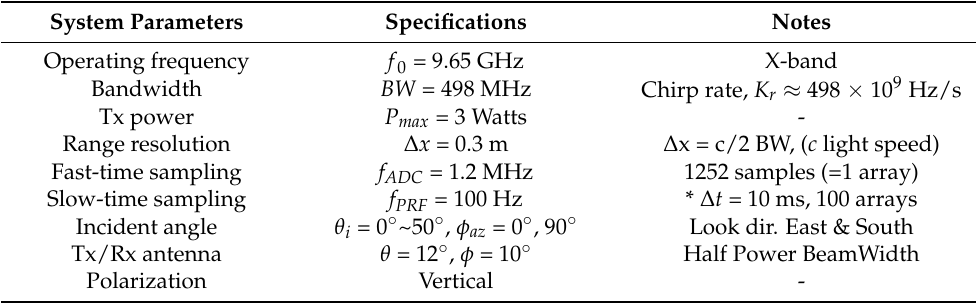
Figure 1. The appearance of the self-manufactured multifunctional FMCW-scatterometer system installed at the Ieodo Ocean Research Station located about 150 km from Jeju island of Republic of Korea. Table 1. Specification of the self-manufactured FMCW scatterometer system (* time interval for analyzing the self-interferometric phase) [11].